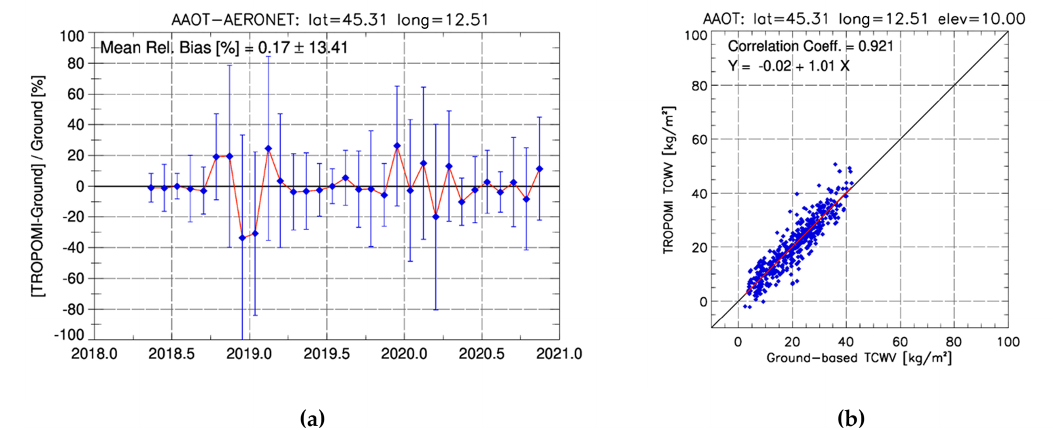
Figure 4. The same as Fig. 3 but for the Northern Hemisphere tower station AAOT, located in the northern Adriatic